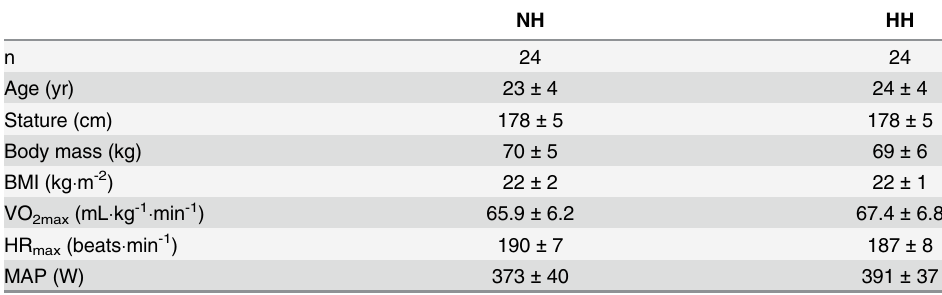
Values are presented as means ± SD. NH, normobaric live-high train-low protocol; HH, hypobaric live-high train-low protocol; N, number of participants; BMI, body mass index; VO 2max , maximal oxygen consumption; HR max, maximal heart rate; MAP, maximal aerobic power during the cycle ergometer